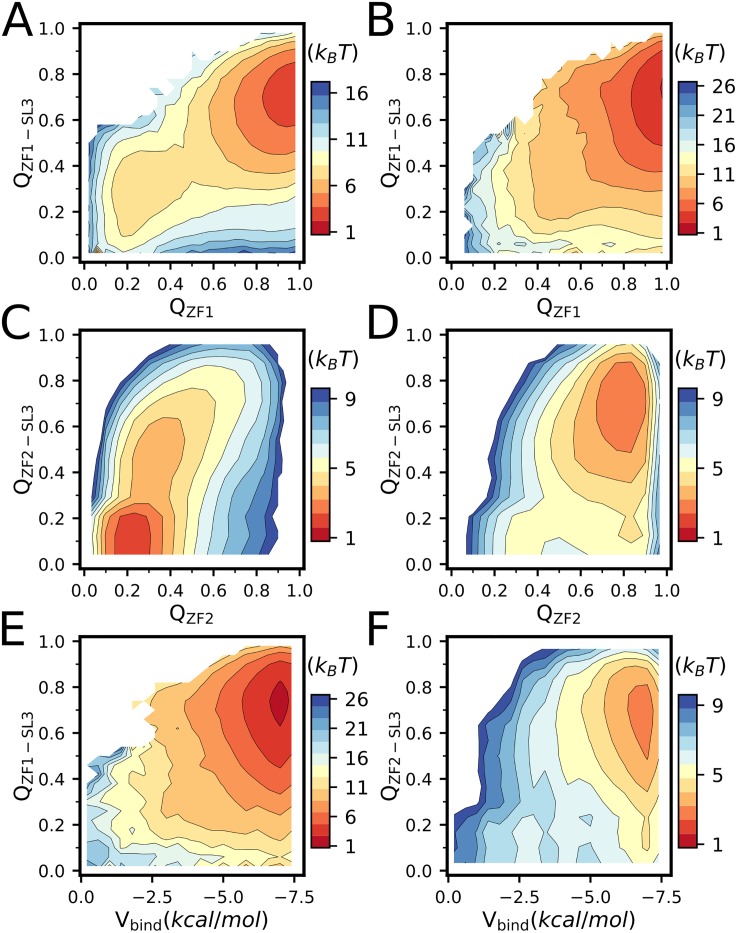
(A, B) Free energy profiles by umbrella sampling projected onto the conformational space formed by QZF1−SL3 and QZF1 without Zn2+(A) and with saturated zinc concentration (B). (C, D) Same as (A, B) but projected onto the conformational space formed by QZF2−SL3 and QZF2. (E) Free energy profiles projected onto the conformational space formed by QZF1−SL3 and the zinc binding energy of the ZF1. (F) Free energy profiles projected onto the conformational space formed by QZF2−SL3 and the zinc binding energy of the ZF2.